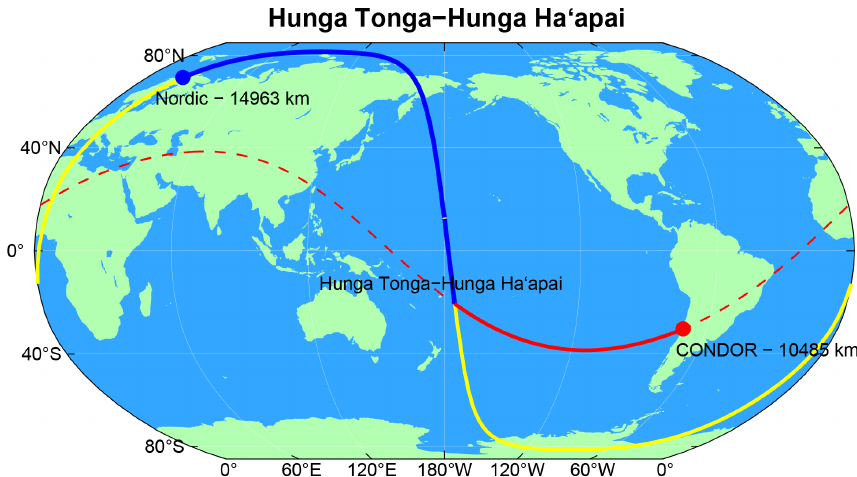
Figure 1. Robinson projection of the globe centered on the Pacific. The solid red line shows the shortest great circle distance between the volcanic eruption and the center of CONDOR. The dashed red line reflects the opposite path along the same great circle. The blue line shows the shortest great circle path from the volcano to the Nordic Meteor Radar Cluster. The yellow line denotes the long path.